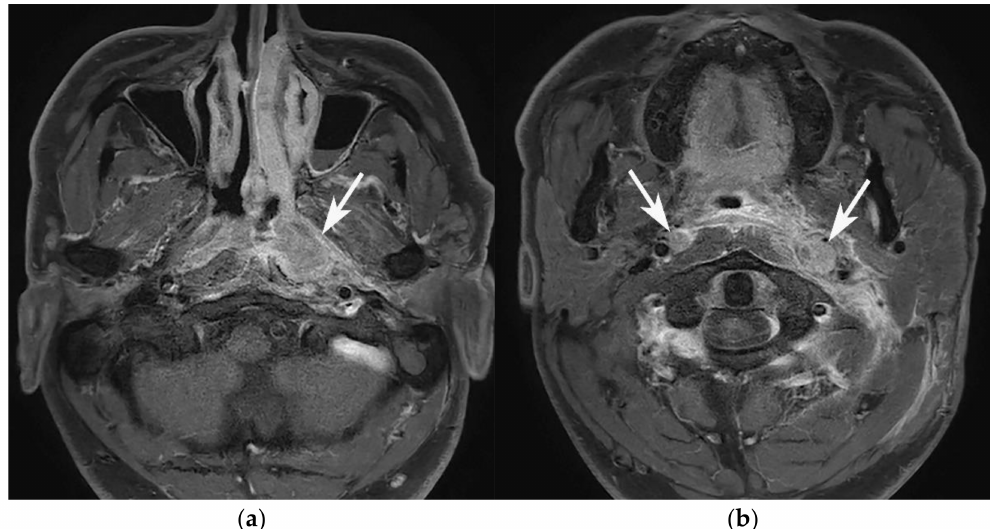
Figure 3. Retropharyngeal lymphadenopathy in a 50-year-old male patient diagnosed with NPC. ( a ) Axial contrast-enhanced T1WI shows enhancing mass-forming lesion in the left posterolateral nasopharynx (arrow). ( b ) In this patient, bilateral retropharyngeal lymph nodes are enlarged (arrows), suggesting retropharyngeal nodal metastases.